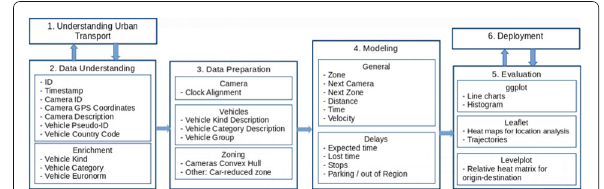
Fig. 1 Our methodology for analyzing observations of ANPR cameras